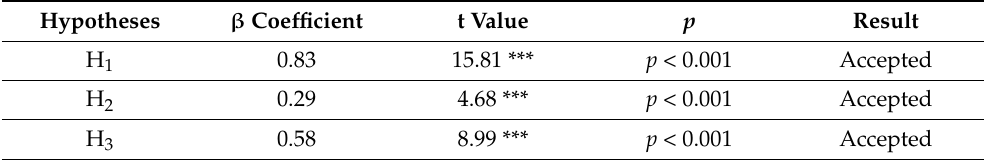
Table 5. Tested result of hypotheses.